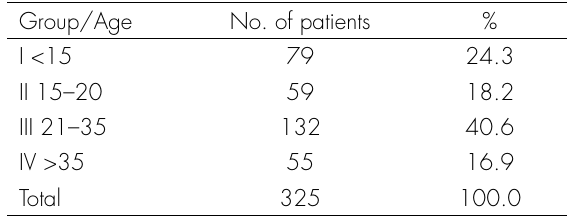
Table I. Characteristics of included